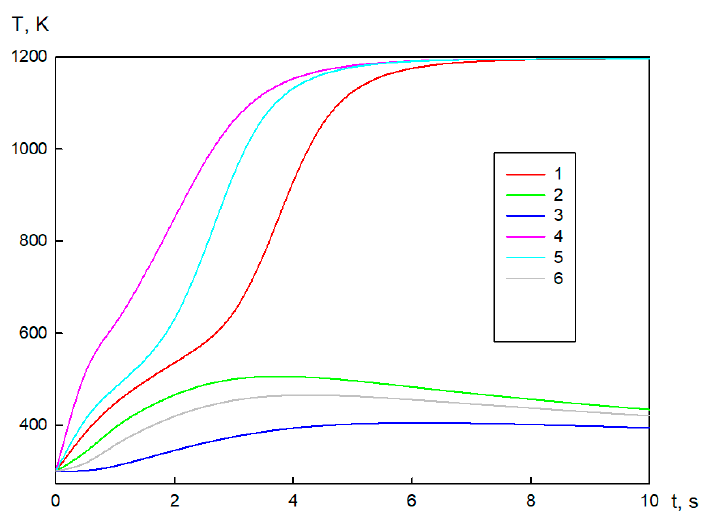
Figure 5. Temperature change over time: ∆ t = 0, d = 15 mm, L = 22 mm, h = 40 mm, 1—h = 32 mm, 2—h = 45 mm, 3—h = 59 mm, 4—h = 12 mm, 5—h = 26 mm, 6—h = 55 mm.